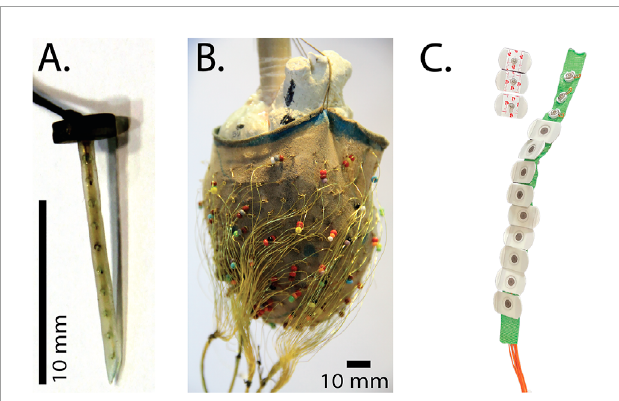
FIGURE 2 Electrical recording arrays used to measure cardiac bioelectric potentials in the experimental models. (A) A plunge needle electrode (B) a 247-lead electrode sock suspended over a plaster model during fabrication, and (C) A strip of torso electrodes containing 12 disposable